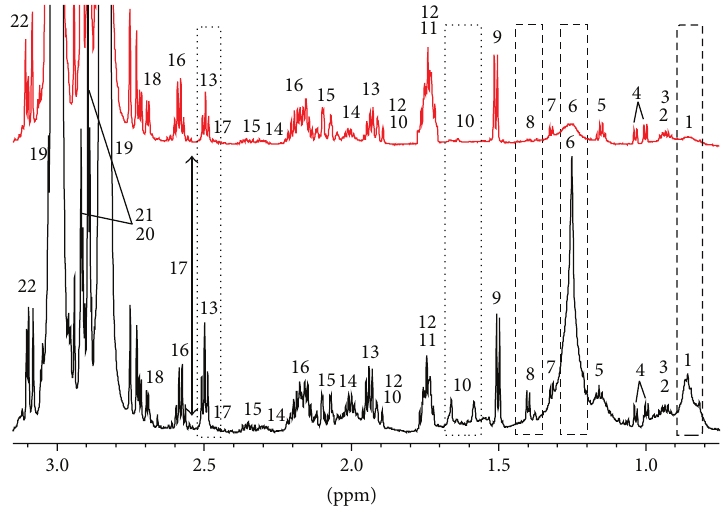
Figure 4: Comparison between the one-dimensional proton spectra of the lemon juice from PGI Interdonato lemon of Messina (red line) and Interdonato Turkish lemon (black line) in the region of amino acids. 1: saturated fatty acids, 2: isoleucine, 3: leucine, 4: valine, 5: ethanol, 6: unsaturated fatty acids, 7: threonine, 8: lactic acid, 9: alanine, 10: arginine, 11: DSS, 12: lysine, 13: GABA, 14: proline, 15: glutamic acid, 16: glutamine, 17: isocitric acid, 18: aspartic compound, 19: citric acid, 20: malic acid, 21: asparagine, and 22: